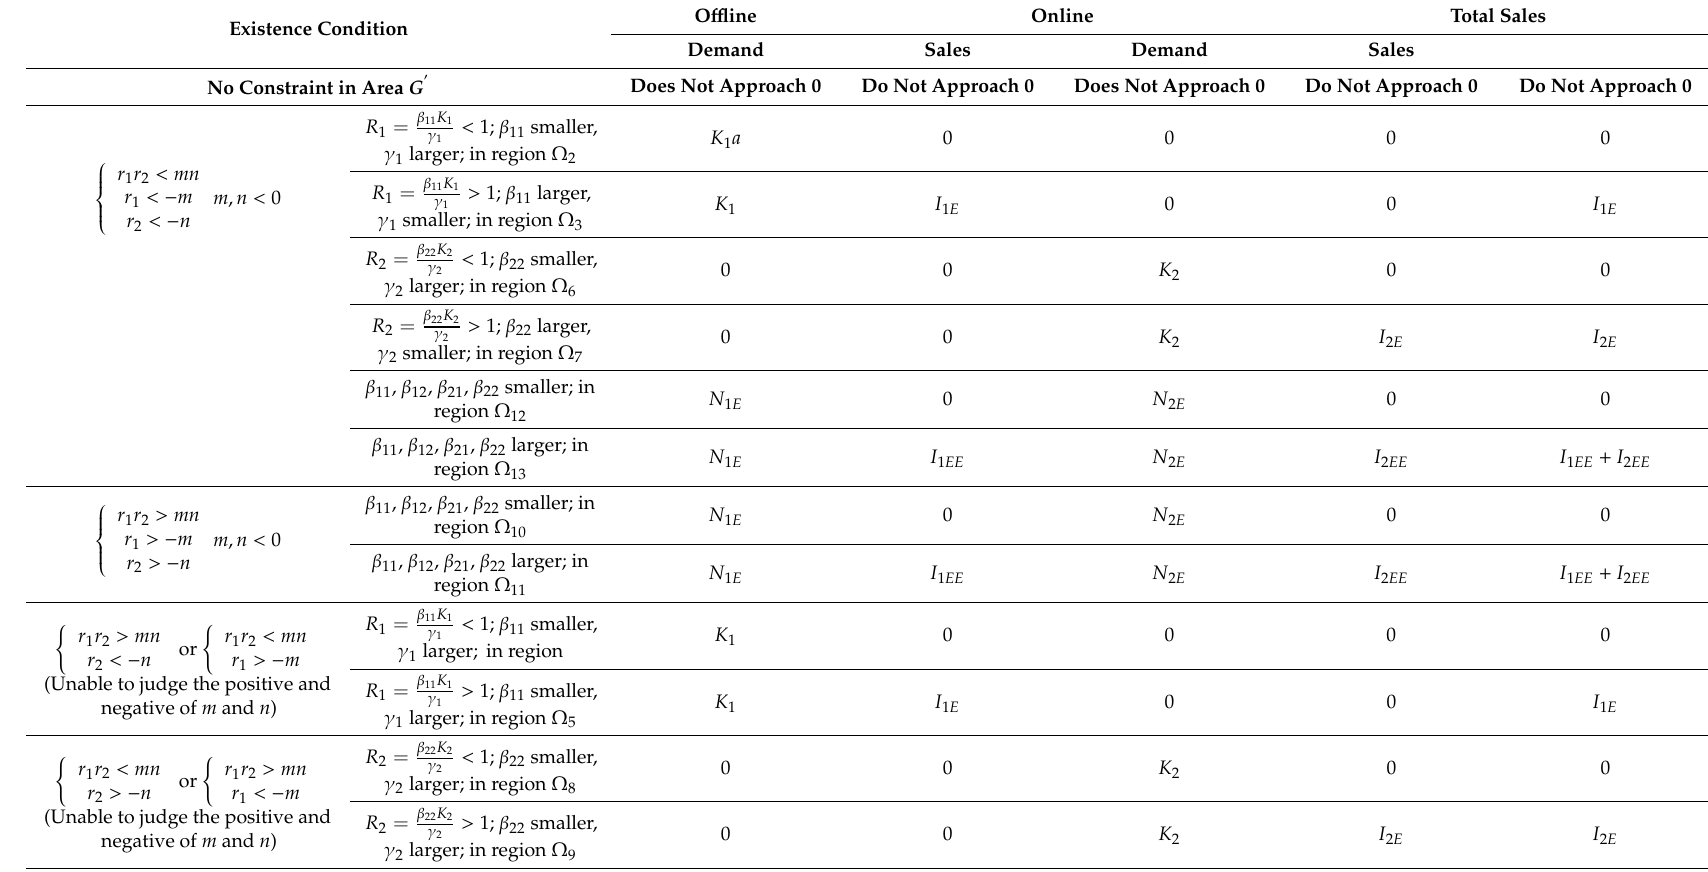
Table 4. Stability of the dual-channel pharmaceutical supply